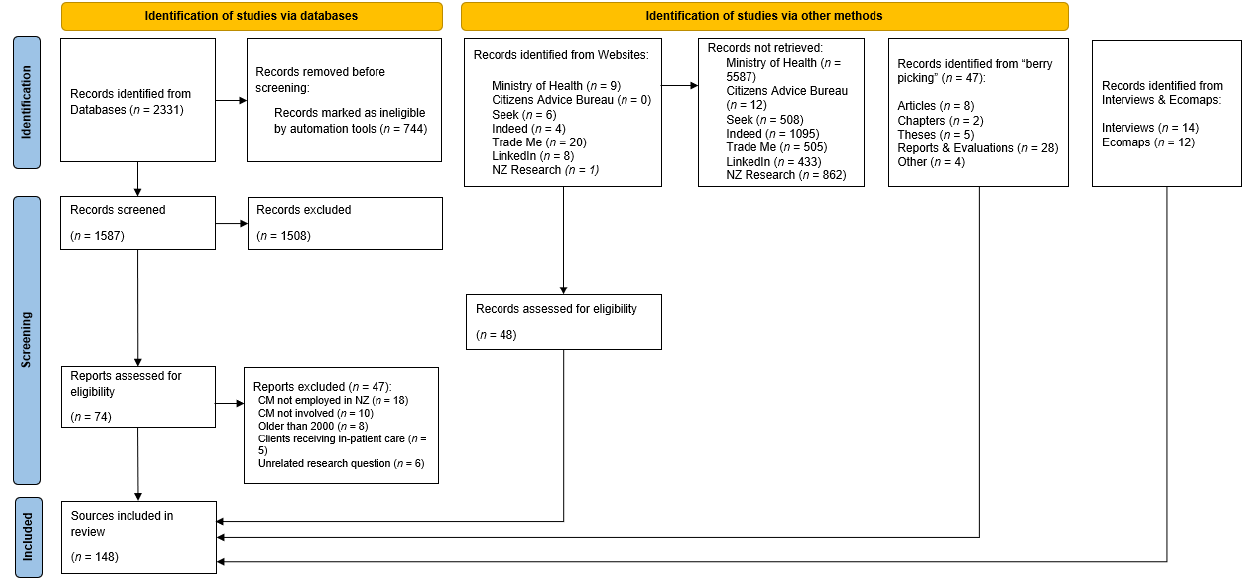
Figure 2. Flow of information through the review: PRISMA.